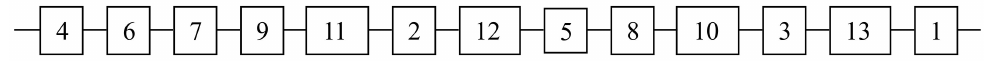
Figure 4. The series system representing the intact precast concrete